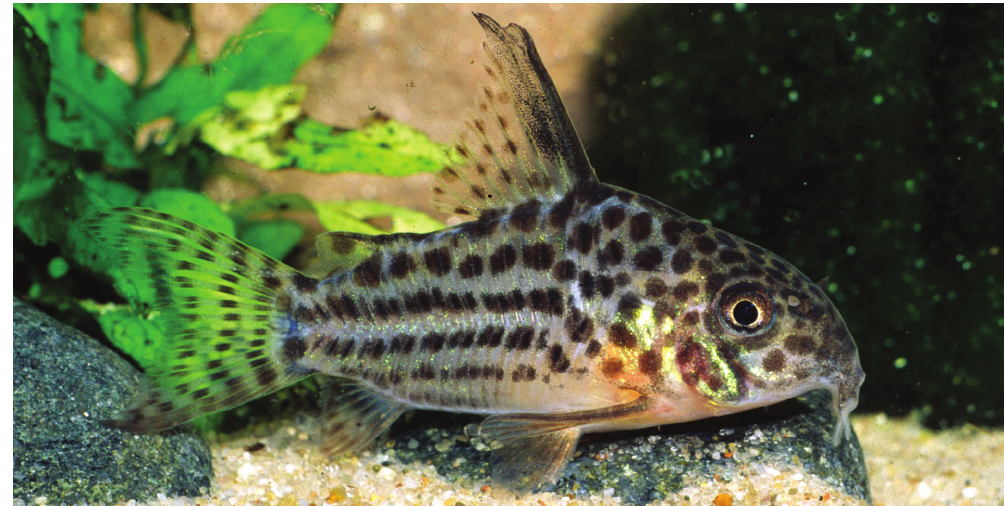
Fig. 8. Uncatalogued aquarium specimen of Corydoras araguaiaensis attributed to C45, showing the general color pattern of the species in lateral view. Photo by Hans-Georg